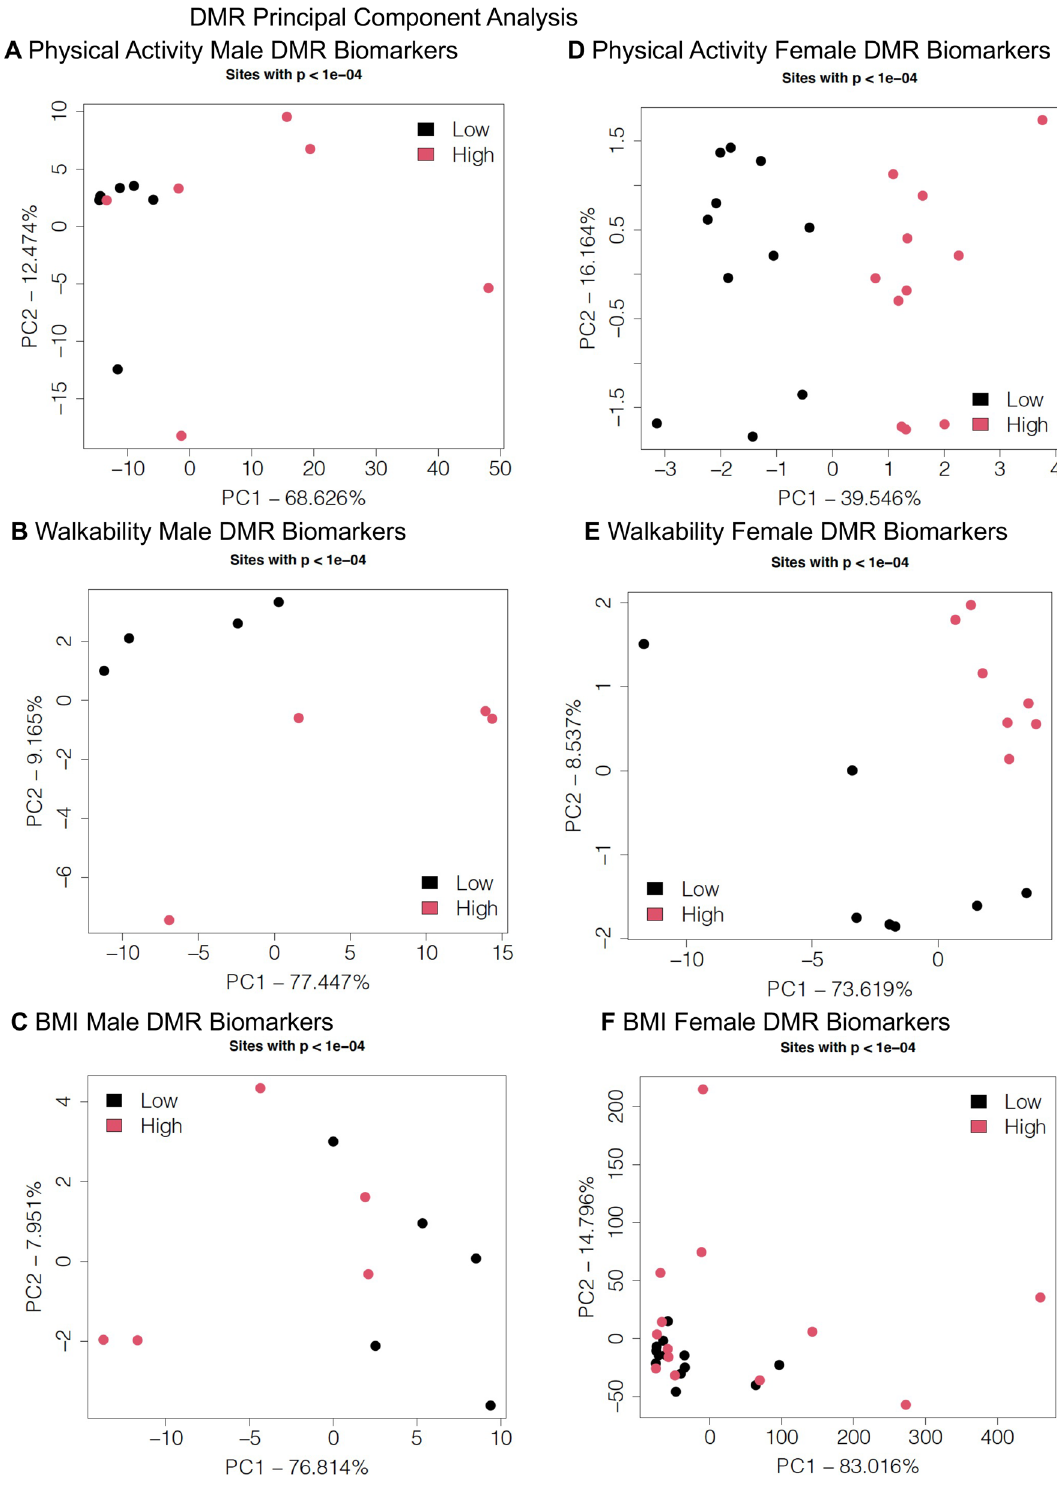
Figure 5. DMR principal component analysis. ( A ) Activity male DMR biomarkers; ( B ) Walkability male DMR biomarkers; ( C ) BMI male DMR biomarkers; ( D ) Activity female DMR biomarkers; ( E ) Walkability female DMR biomarkers; and ( F ) BMI female DMR